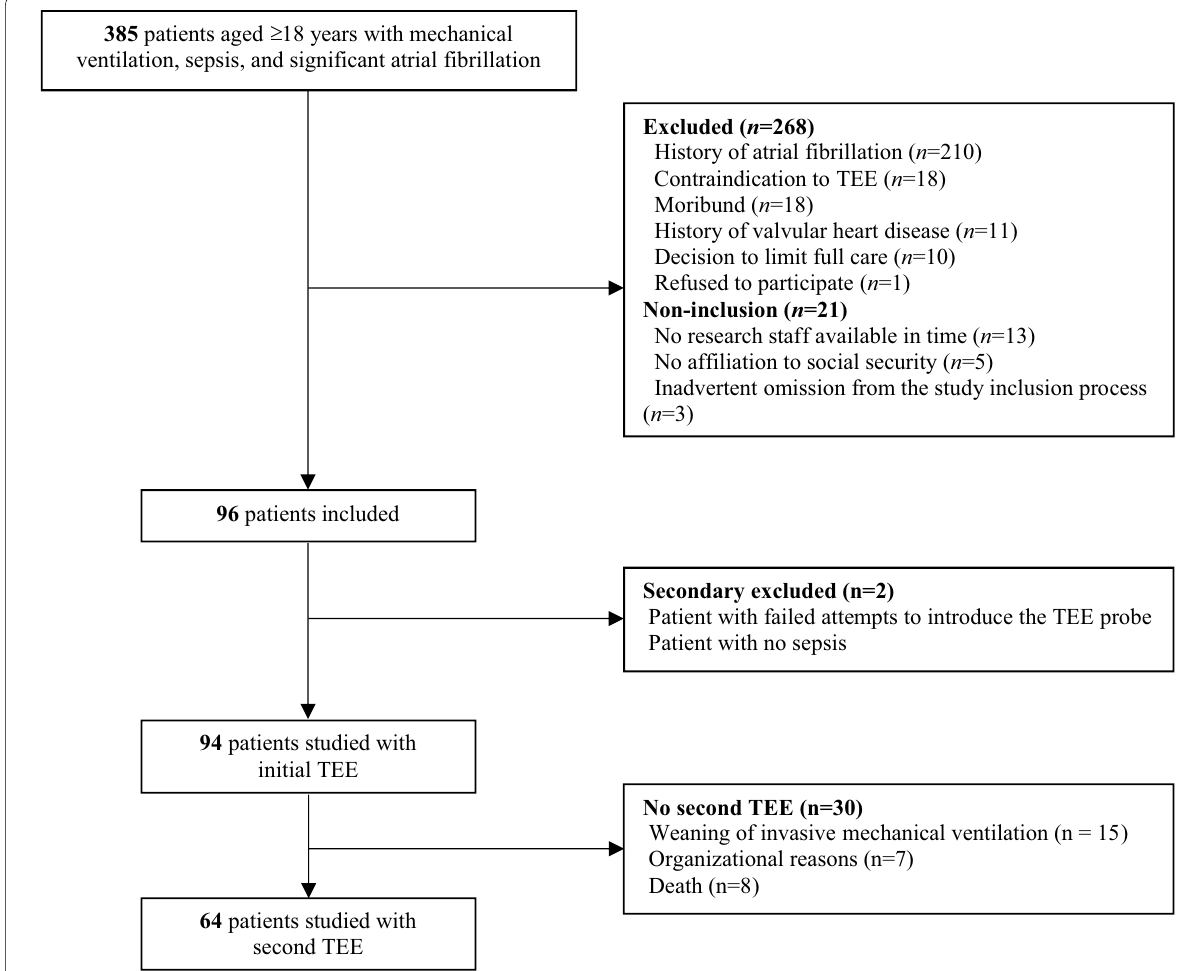
Fig. 1 Patient flowchart. TEE transesophageal